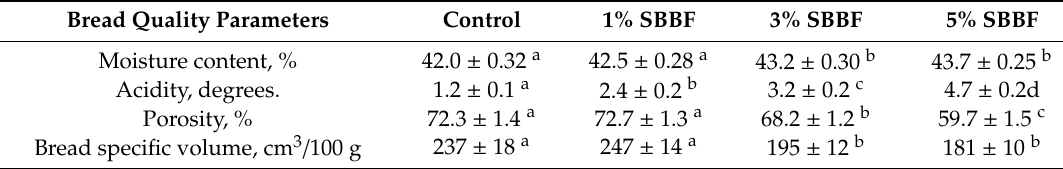
Table 4. Influence of di ff erent quantities of sea buckthorn berry flour (SBBF) addition on wheat bread quality (errors represent the standard deviations of three replicates and di ff erent letters designate statistically di ff erent results).